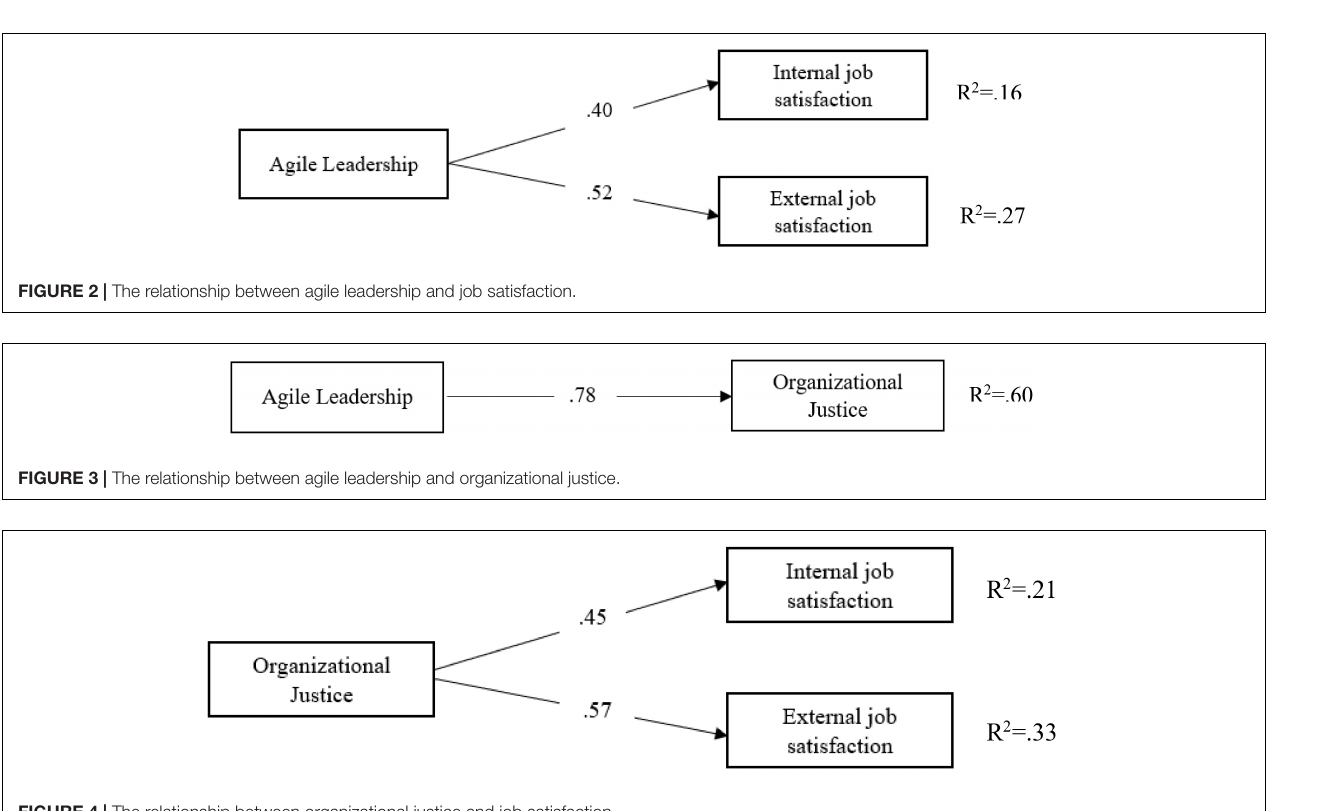
FIGURE 4 | The relationship between organizational justice and job satisfaction. TABLE 3 | Regression values between